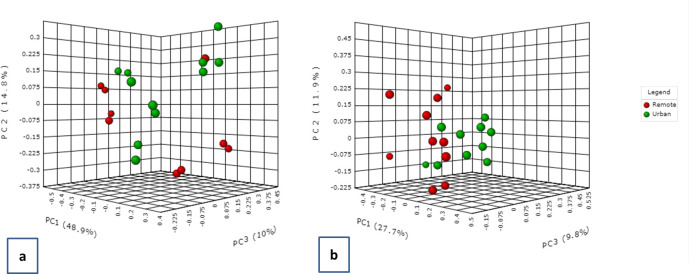
Beta diversity clustering based on PCoA on the Bray Curtis distances of (a) bacterial genus and (b) fungal genus distributed between two locations in Kuwait. The two colours represent the two sites Abdally/remote and Kuwait city/urban.